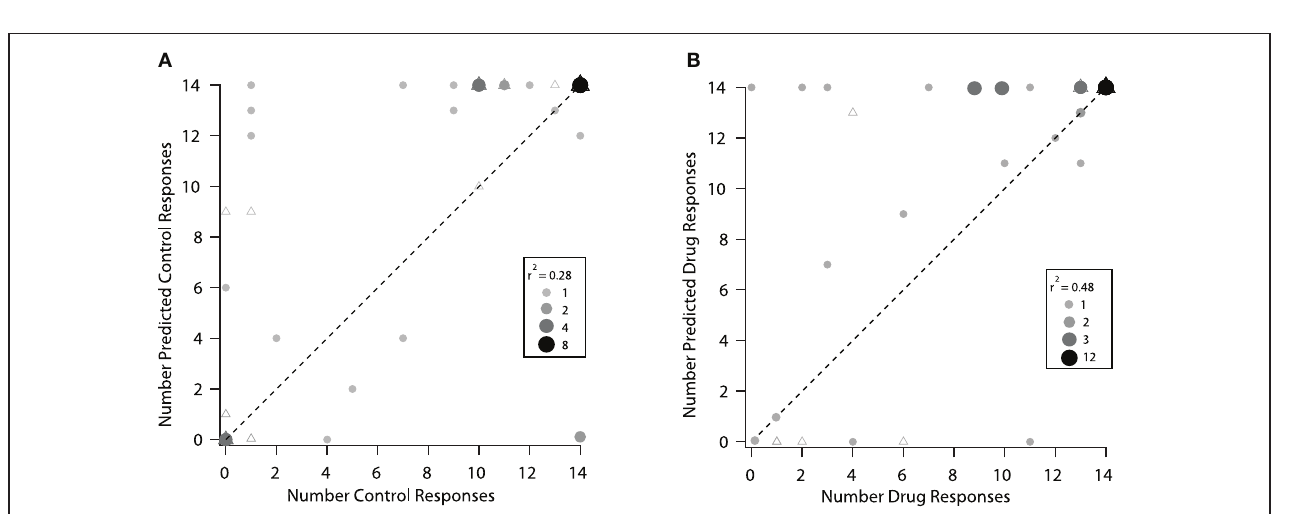
FIGURE 8 | Predicted responses to vocalizations based on the excitatory frequency tuning curves were better under drug conditions. (A) Control condition. The predicted number of vocalizations to evoke a response is plotted vs. the actual number that evoked a response for each neuron. (B) Same neurons are plotted under the drug condition. The triangles represent neurons that showed a change in rate and a change in the shape of their excitatory frequency tuning curve and circles represent neurons that showed a change